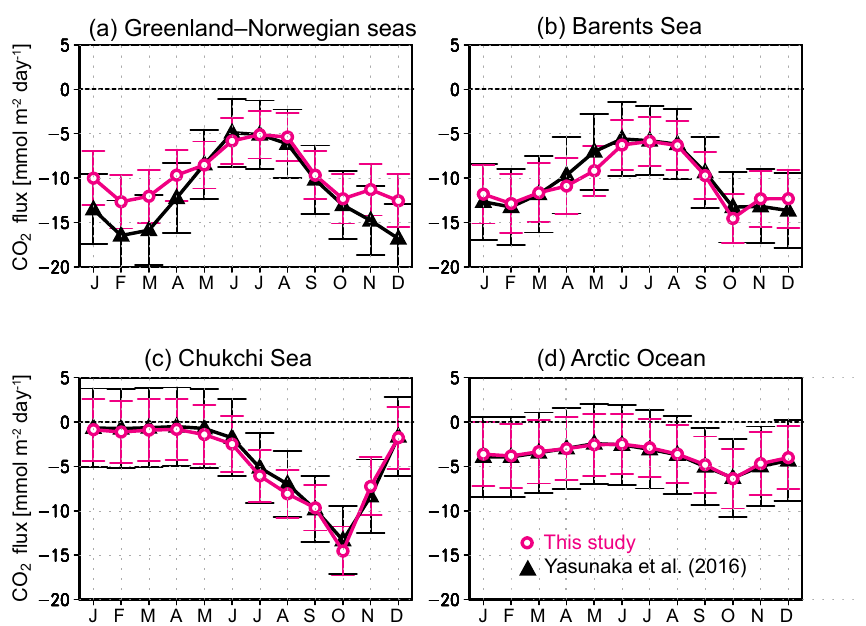
Figure 14. The 18-year monthly mean CO 2 flux (mmolm − 2 day − 1 ) averaged over (a) the Greenland and Norwegian seas, (b) the Barents Sea, (c) the Chukchi Sea, and (d) the Arctic Ocean. Black lines with triangles show estimates without Chl a by Yasunaka et al. (2016); magenta lines with open circles show estimates with Chl a . Error bars show the uncertainty, estimated as described in the